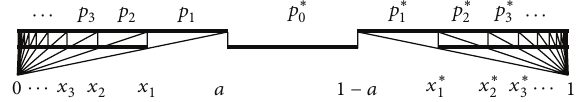
Figure 16: Construction scheme for density 𝑝(𝑥) , extra intervals marked, 𝑎 = (3 − √5)/2 , case of 𝑛 = 2